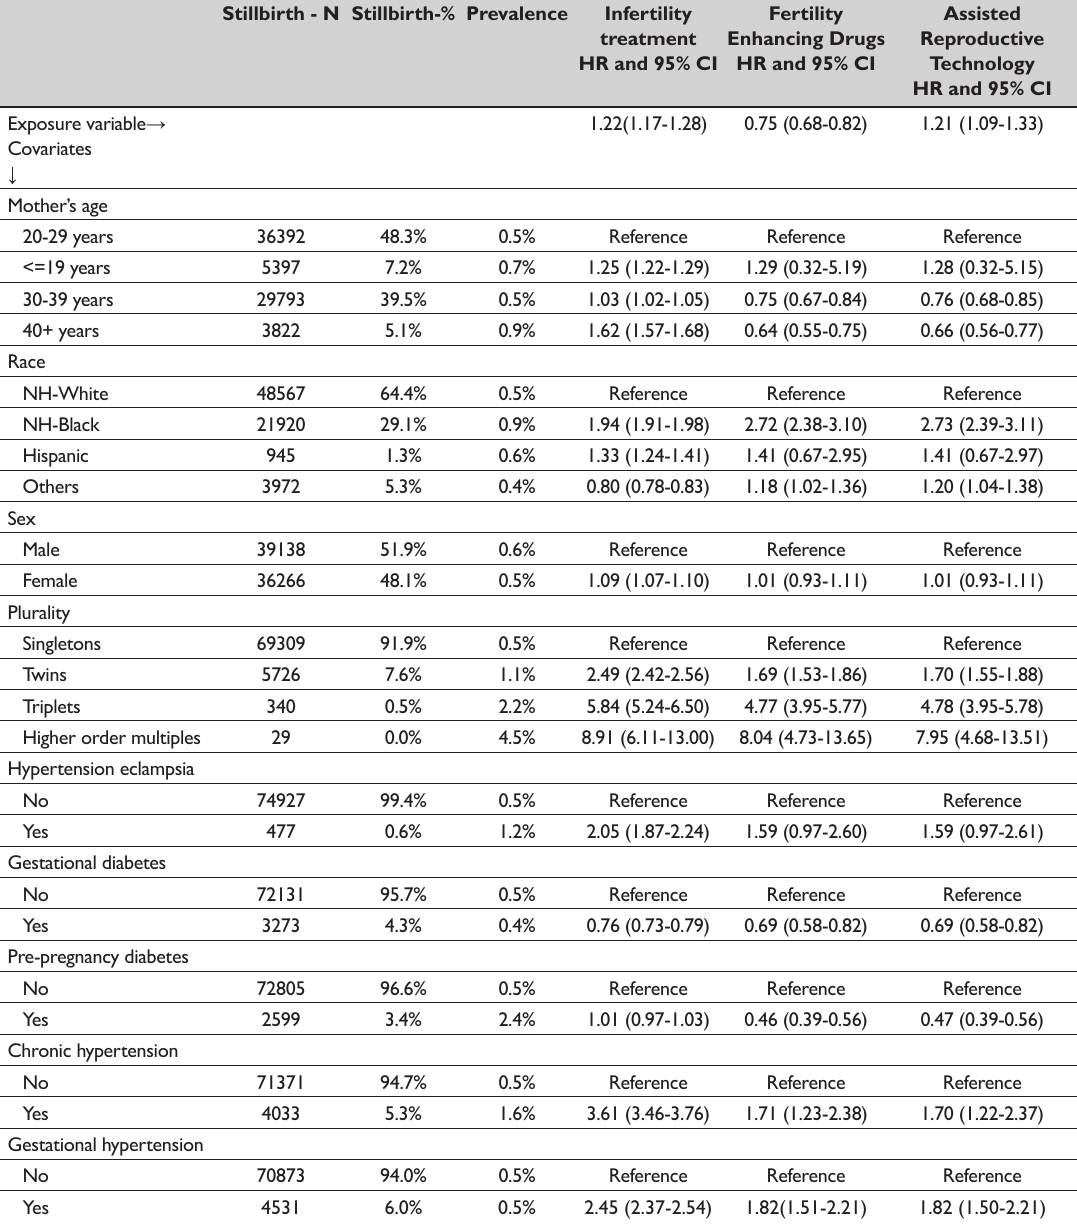
Table1: Prevalence and Cox proportional hazards regression results for infertility treatment, fertility enhancing drugs and assisted reproductive